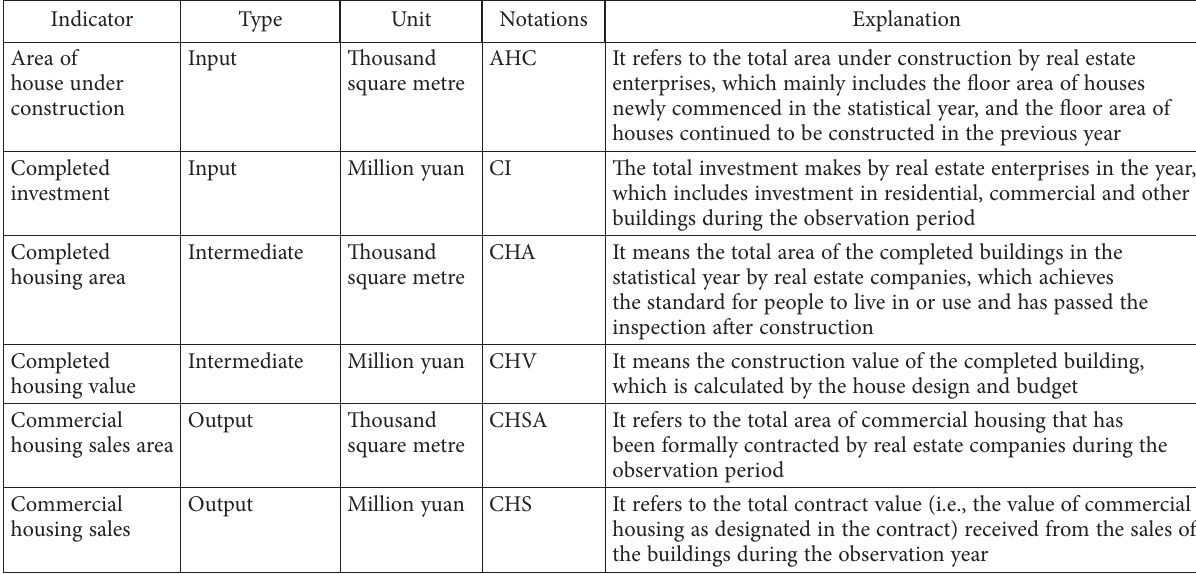
Table 2. The descriptions of the indicators used in this